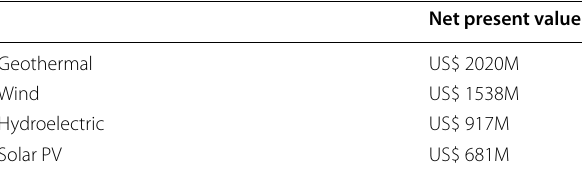
Table 1 Net present value of various renewable energy investments